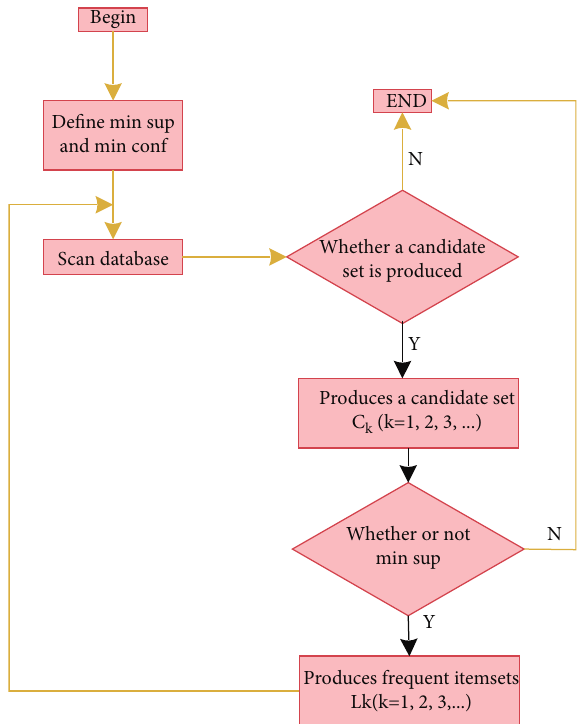
Figure 1: Flow chart of association rules method for compre- hensive ability evaluation system of senior high school English